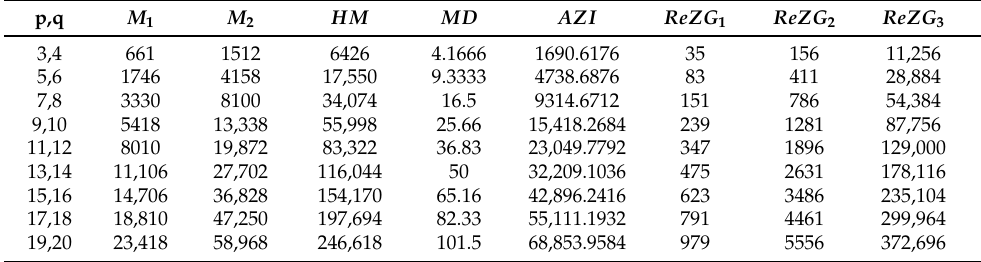
Table 4. Zagreb indices of SC p q for p < q and p is